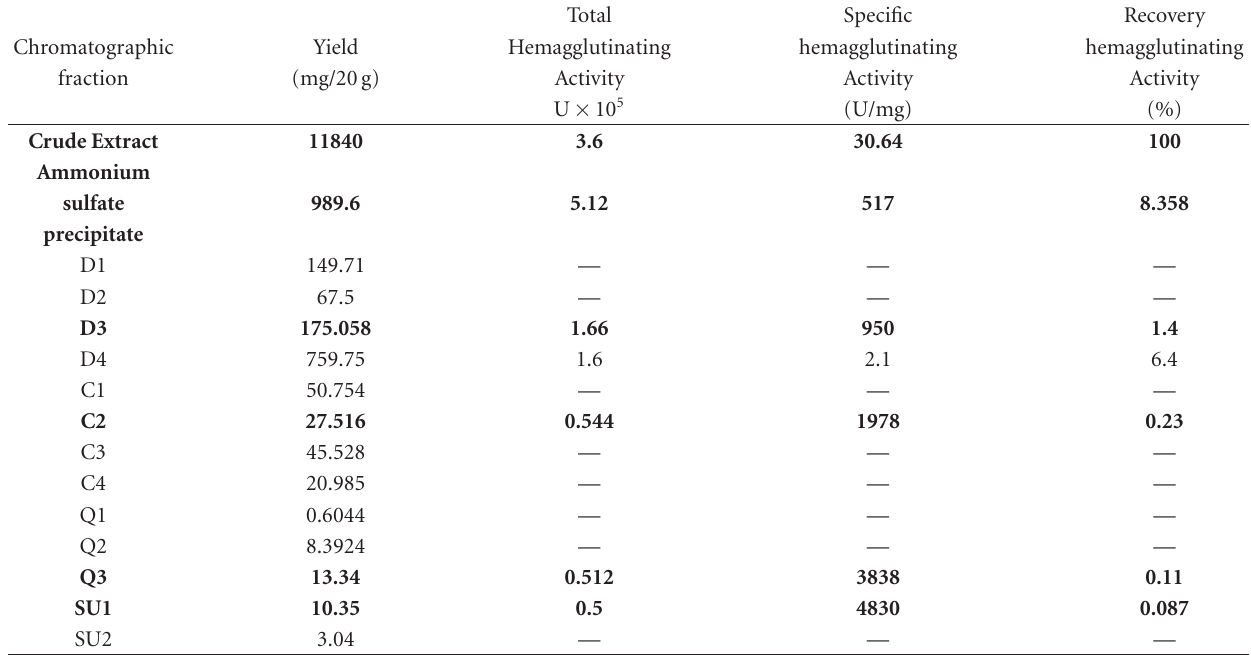
Table 1: Summary of purification of HEA (from 20g dried fruit